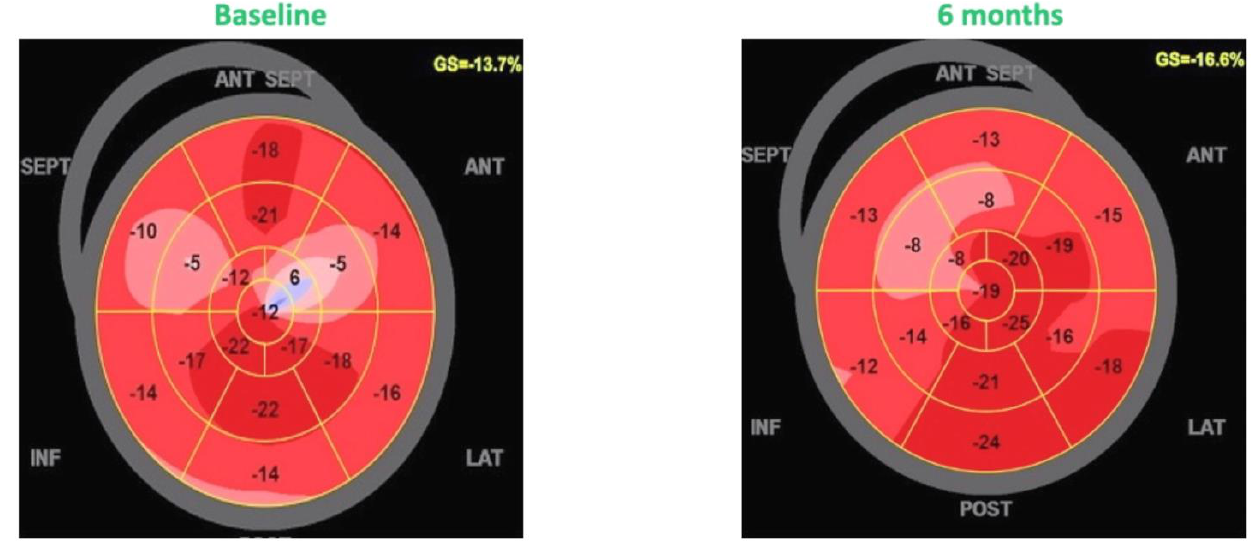
Figure 1. Effects of CCM on global longitudinal strain.